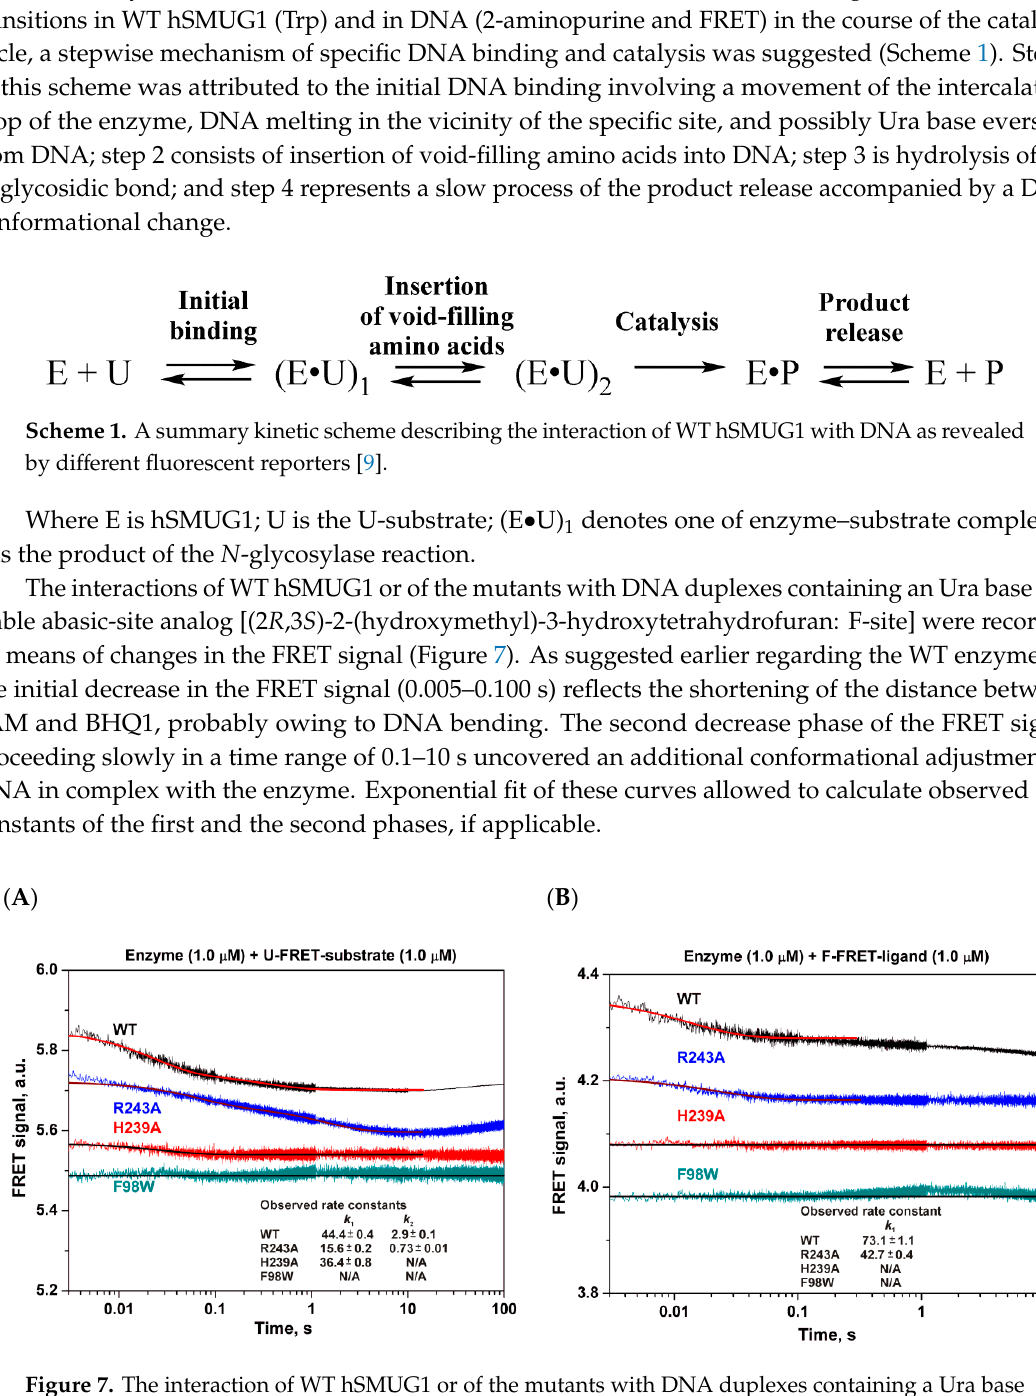
Figure 6. Accumulation of the reaction product ( A ) and relative activity ( B ) of WT hSMUG1 and mutants F98W, H239A, and R243A during the interaction with the model DNA duplex containing a U/G pair as determined by PAGE. [Enzyme] = 1.0 × 10 − 6 M, [Substrate] = 5.0 × 10 − 6 M.